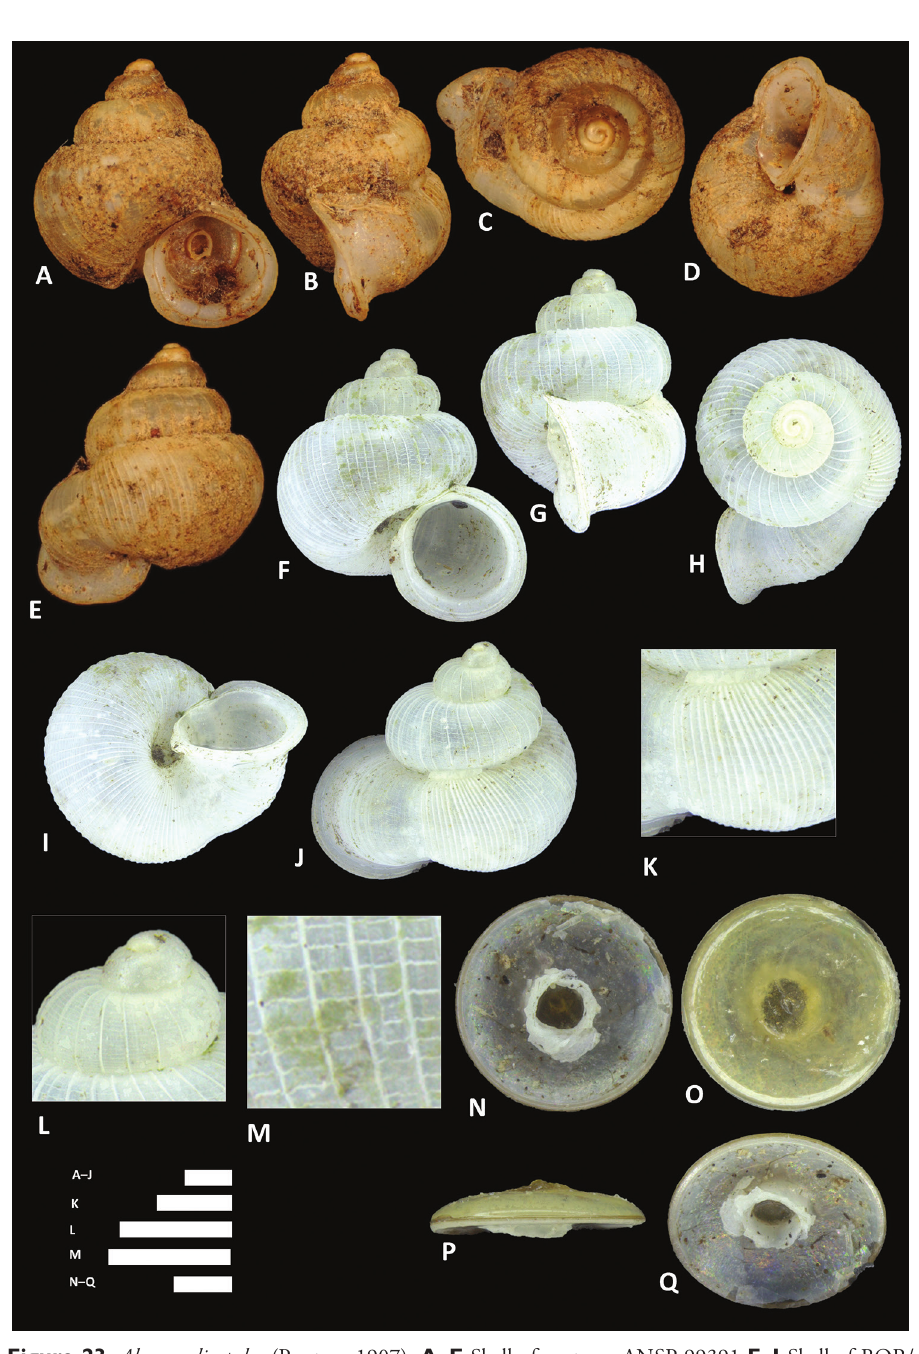
Figure 23. Alycaeus liratulus (Preston, 1907). A–E Shell of syntype, ANSP 99391 F–J Shell of BOR/ MOL 6831 K–M Close up of shell of BOR/MOL 8357 N–Q Operculum of BOR/MOL 6832. Scale bars: A–J 1 mm; K, L 1 mm; M, N–Q 0.5 mm. Photographs A–E by the Malacology Department, ANSP. Photographs F–Q by Junn Kitt